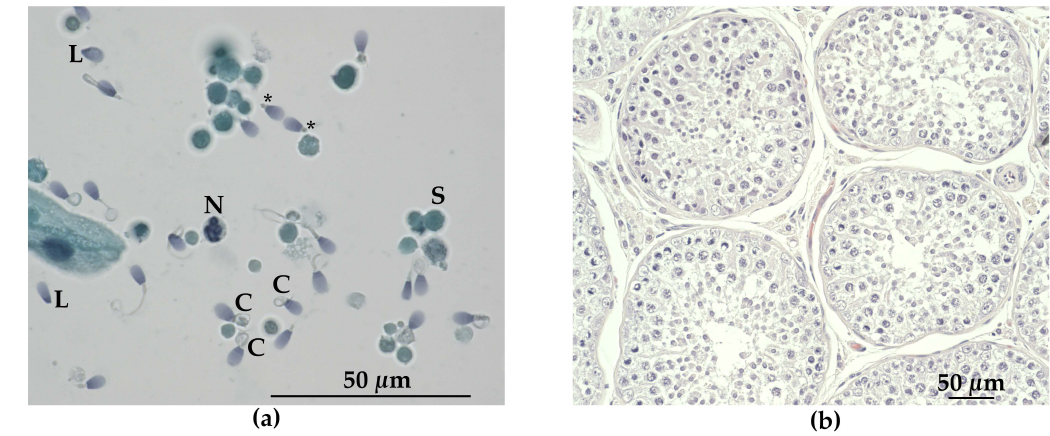
Figure 5. Light microscopy of sperm and seminiferous tubules from the a ff ected male (GR01). ( a ) Papanicolaou staining of semen showing several abnormal spermatozoa. Di ff erent tail defects are evident, including coiled tails (C), tail stumps (*) and loose heads (L). S: spermatogenic cell, N: neutrophil leukocyte. ( b ) Tubuli seminiferi in testis stained with hematoxylin and eosin, showing mainly early stages of spermatogenesis and few elongated spermatids